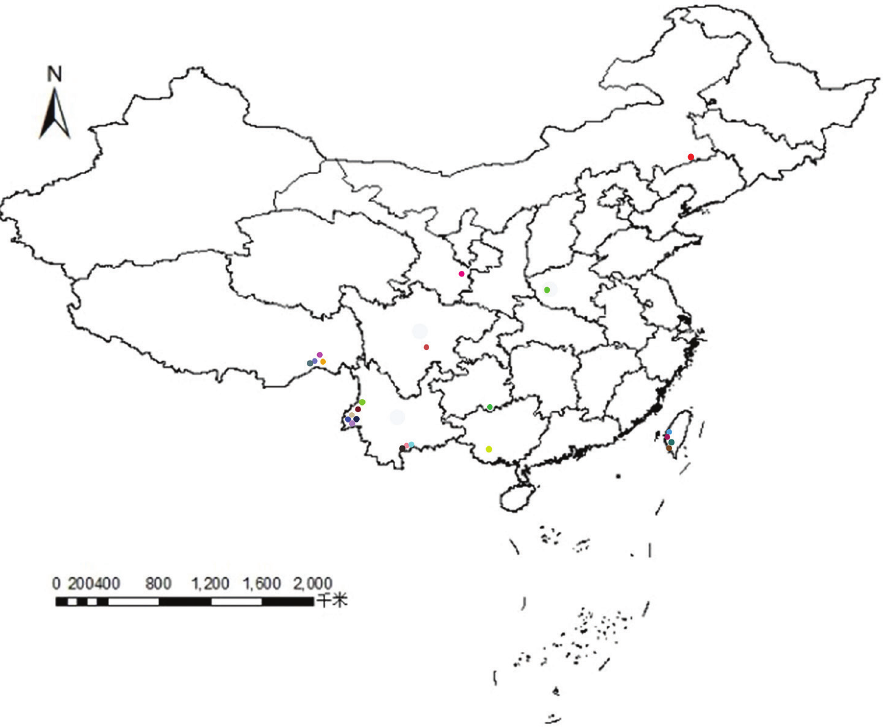
Figure 31. The distribution of Phyllomyza species in